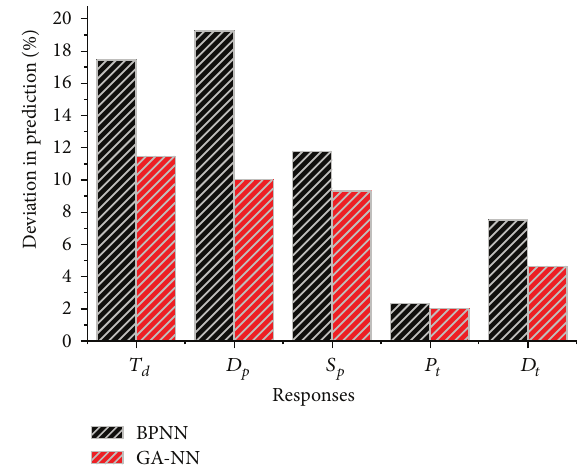
Figure 9: Comparison of two models in terms of average absolute percent deviation in prediction of the test cases for process parame-